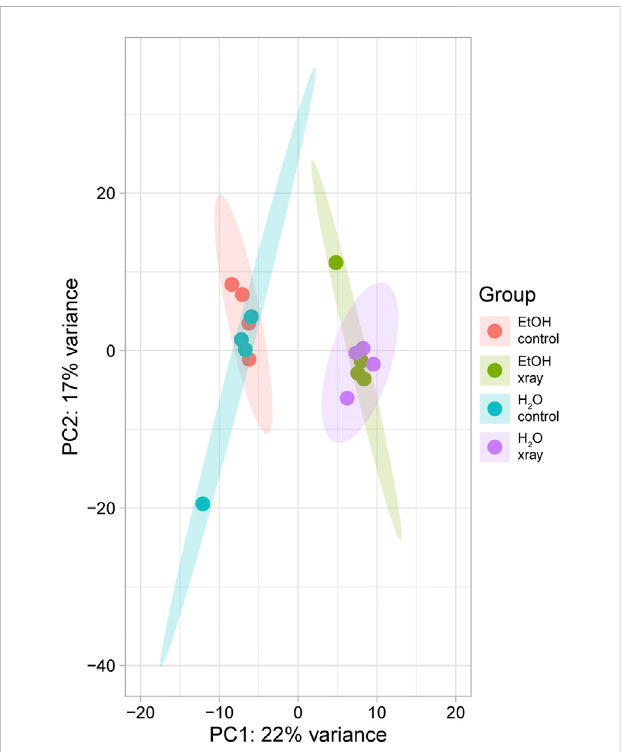
FIGURE 1 Principal component analysis of variability of gene expression in RNA-seq data from ethanol (EtOH) and water-fed non-irradiated (control) and irradiated (xray) mosquitoes. Points represent individual biological replicates (n = 4) from each treatment, and surrounding ovals represent 95% con fi dence